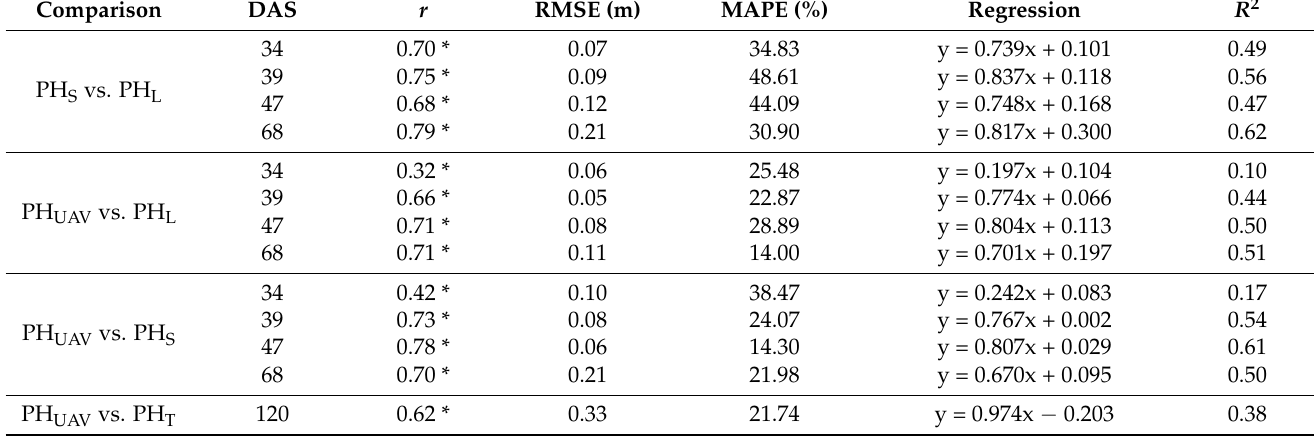
Table 2. Predictive analytics of the height of the highest leaf (PH L ), the highest straightened leaf (PH S ), the tassel tip (PH T ) and the estimated plant height by UAV (PH UAV ); DAS: days after sowing, error, R 2 : coefficient of